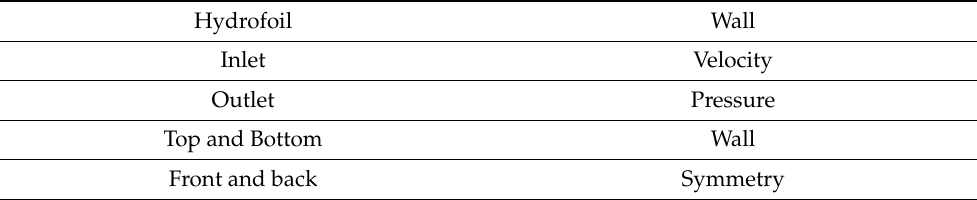
Figure 1. The grid in the lengthwise section and the cross section. Table 1. Boundary conditions.